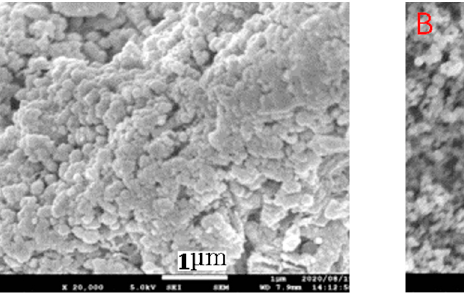
Figure 3. Geometry of the cup-shaped specimen produced ( A ) and the research methodology flowchart ( B ). 2.4. Measurement of the Electrical Resistivity The electrical resistivities of the new conductive concrete materials were measured using a chemical impedance analyzer (model: IM3590) manufactured by Hioki Co., Ltd., Nagano, Japan, based on the widely used four-electrode method [25]. These specimens were cured in water for 27 days, considering that the actual con- duits are wet. Because concrete contains several electrolytes, the electrical resistivity changes with the application time. The electrical resistivities reported in this study were the values after 5 min, which were confirmed by the preliminary experiments that became stable, even in the low-frequency region, where it takes a longer time to converge to a constant value. The applied voltage and power frequency during the measurements were set to 0.3 V and 50 Hz, respectively. 2.5. Sulfide Adsorption Experiments To confirm that the concrete materials do not contribute significantly to the effect of the sulfide reduction, San-earth (S50), Denka Black (D10), and magnetite (M50) tests were performed to determine the adsorption capacity. Three vials containing 100 mL of